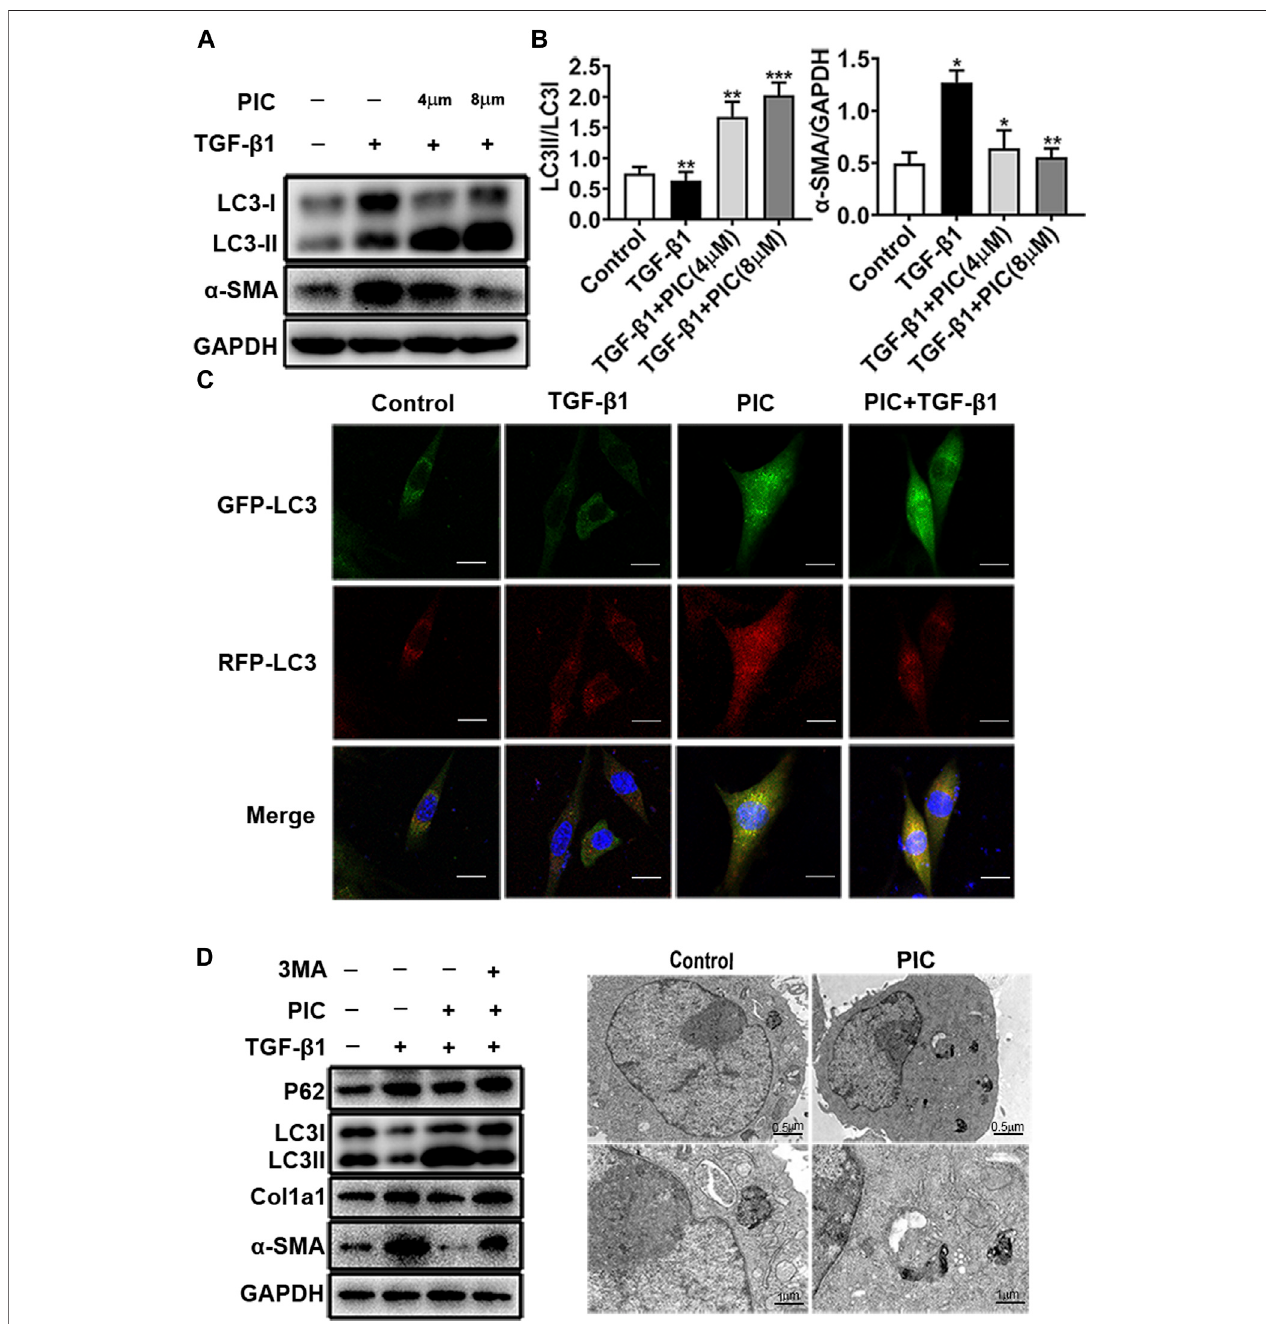
FIGURE 2 | (A) ProteinexpressionsofLC3I,LC3II,and α -SMAinNIH-3T3cellstreatedwith5 ng/mlTGF- β 1withorwithoutPIC(4 μ Mand8 μ M)for24 h. (B) Quantitative WesternblotanalysisofLC3I/LC3II/ α -SMAcomparedtoGAPDHindifferentgroups. (C) NIH-3T3cells,transfectedwiththeplasmidmRFP-GFP-LC3,weretreatedwithPIC(4 μ M) for24 hintheexistenceorabsenceofstimulationbyTGF- β (5 ng/ml).GFPandRFPwereshownasLC3-positivecellsandDAPIasnuclear. (D) ProteinexpressionsofLC3I,LC3II, P62,Col1a1, α -SMA,andGAPDHinlung fi broblasts(NIH-3T3)treatedwith5 ng/mlTGF- β 1,3 MA(2 mM)withorwithoutPIC(4 μ M)for24 h. (E) Representativeimagesof fi broblastsweretreatedwithTGF- β 1and/orPIC(4 μ M);then,autophagicvesicles(AVs)wereanalyzedbyusingatransmissionelectronmicroscope.Theexpressionofproteinwas performed by ImageJ using GAPDH as a loading control. Data are expressed as mean ± SD, n = 3. * p < 0.05, ** p < 0.01, and *** p < 0.001.